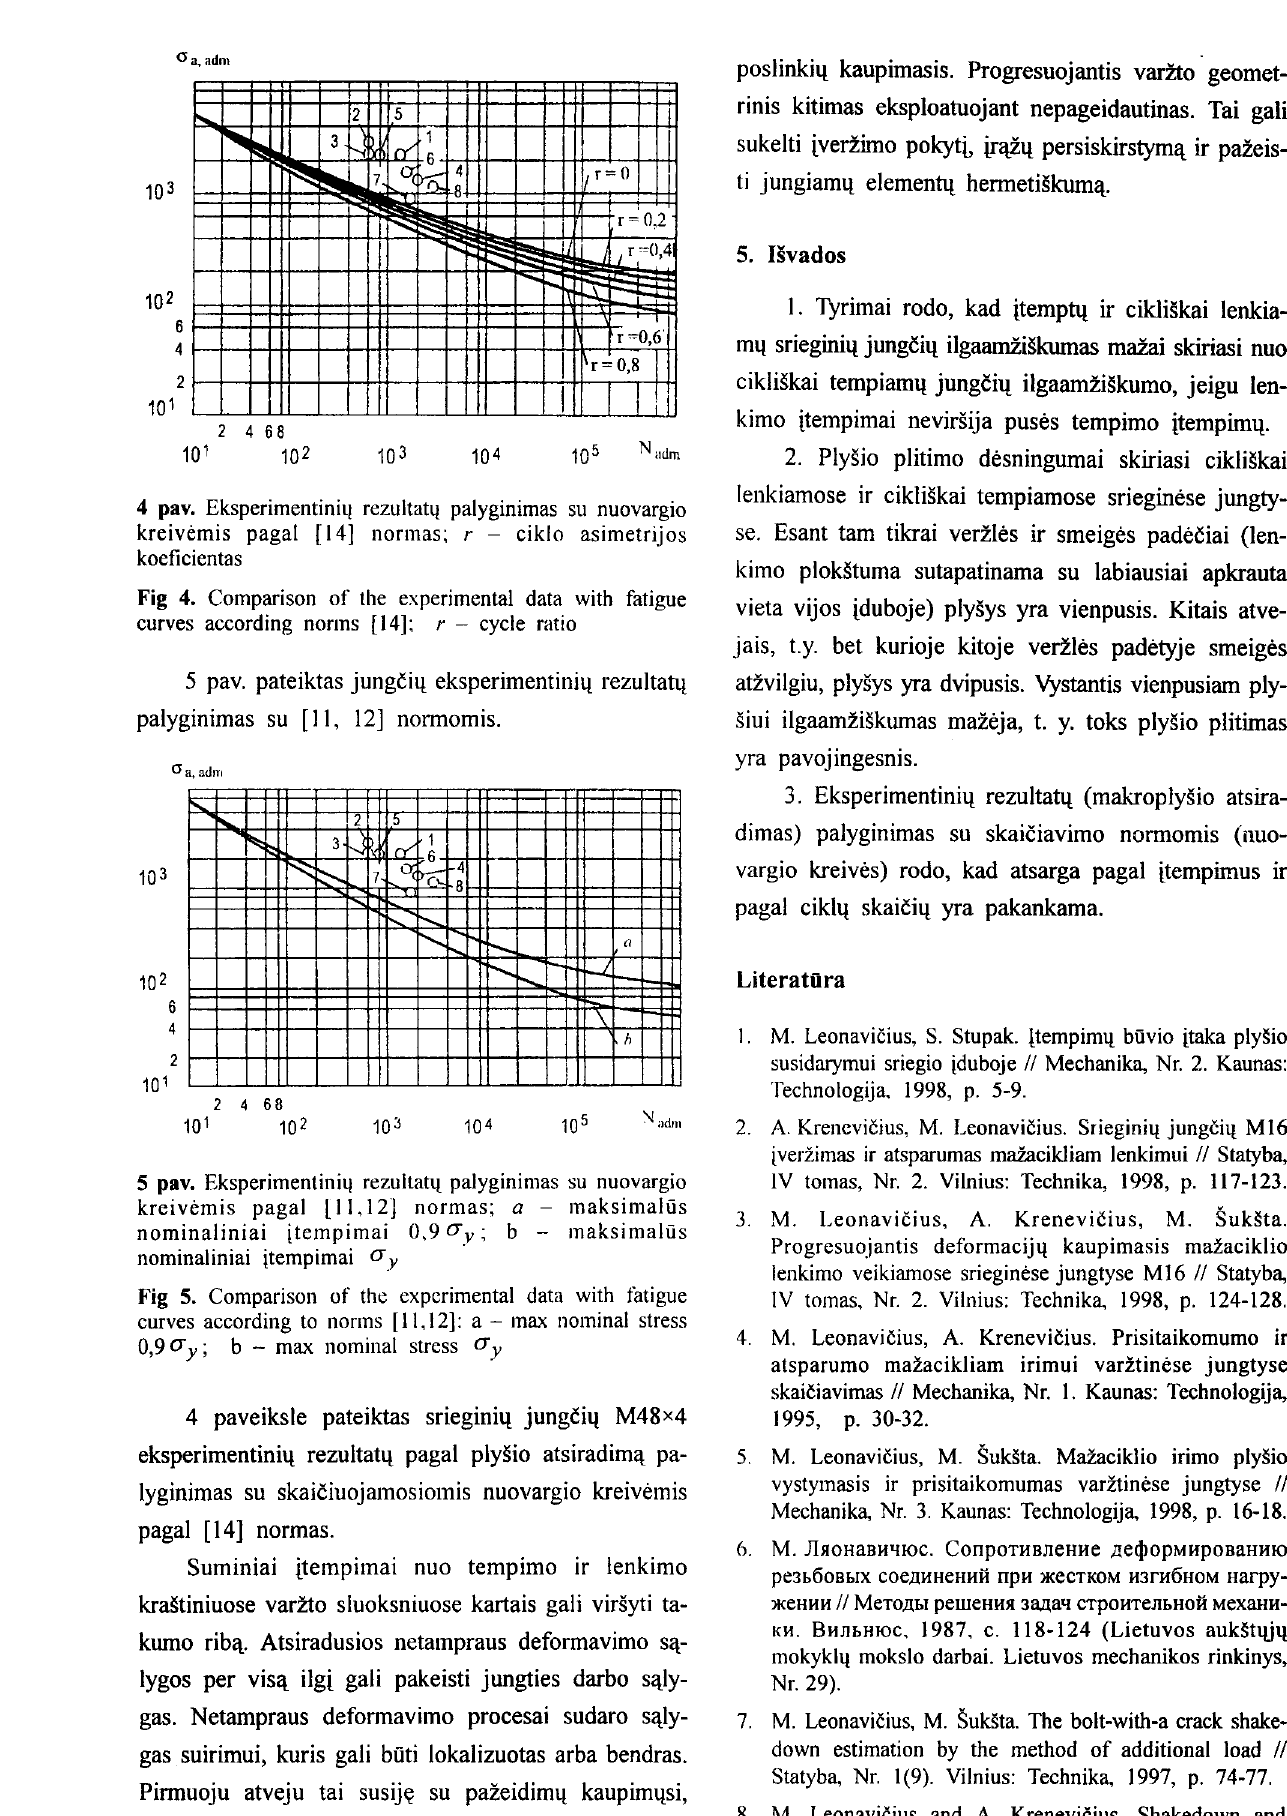
Fig 4. Comparison of the experimental data with fatigue curves according norms [14]; r - cycle ratio 5 pav. pateiktas jungci4 eksperimentini4_ rezultatlj_ palyginimas su [11, 12] normomis.